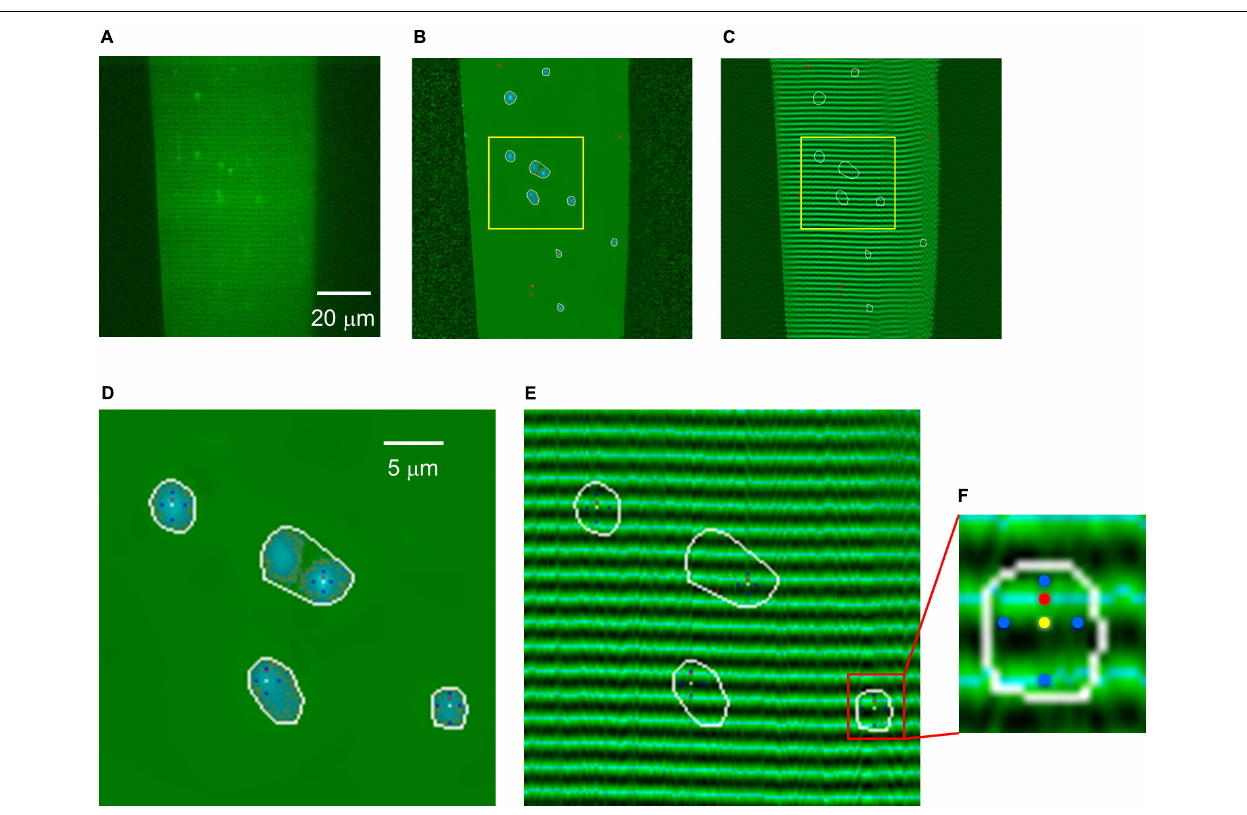
FIGURE 2 | Generation of structure-free normalized image for spark identification and localization. (A) Original x-y image. (B) F/F 0 image to show that the structure was removed and only the sparks are visible. (C) Fiber structure superimposed with areas of sparks. (D) Part of the image in (B) showing four events at high magnification. White curves encircle the areas corresponding to the identified events. Yellow dots present the position of the maxima, while the four blue dots in each event show the orientation of the two axis (perpendicular and parallel to the Z-lines) within the spark. Red pixels represent the position of the fluorescence maximum of Fluo-4, and thus the distance between yellow and red pixels was used to calculate the distance of the center of the spark from the nearest Z-line. (E) Same area as in panel (B) enlarged from panel (C) showing the superimposed Z-lines. The dark bands mark the triads at the Z-lines. (F) A spark enlarged from panel (E) showing the location of color dots described above. Light blue lines show the fluorescence maximum (i.e., the middle of a